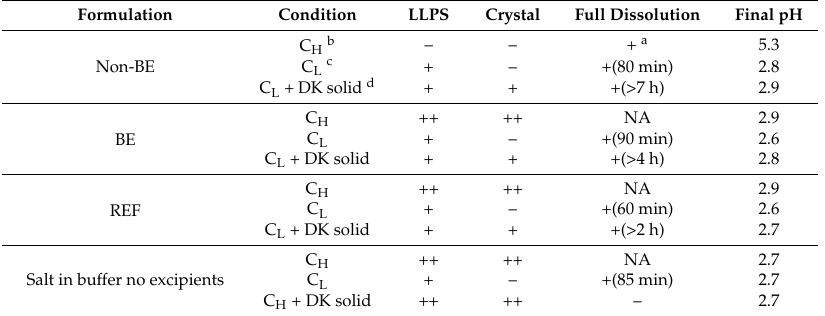
Table 6. Evolution of drug phases during DKT dissolution in different formulation conditions. Formulation